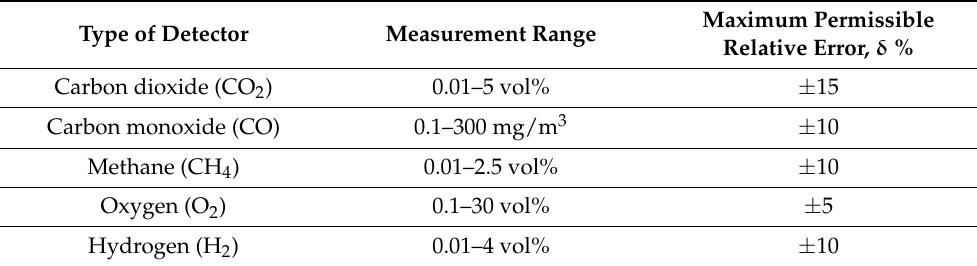
Table 4. Main metrological characteristics of the Senson-SV-5023 gas analyzer